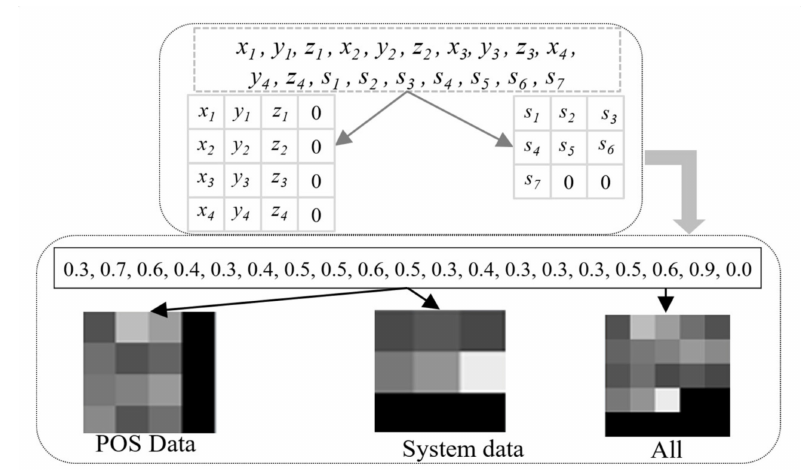
Figure 13. Two-dimensional UAV flight